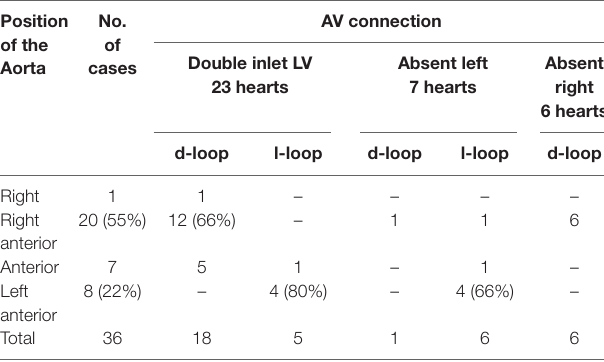
TaBle 11 | Discordant Va connection with univentricular aV connection in situs solitus: relation of the great arteries. Position no. of the of aorta